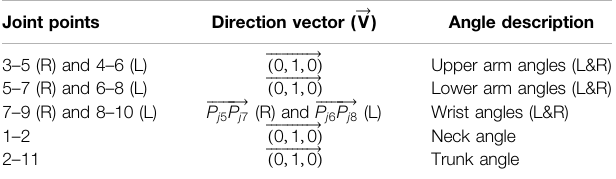
TABLE 2 | Joints used for angles calculation. L:left;